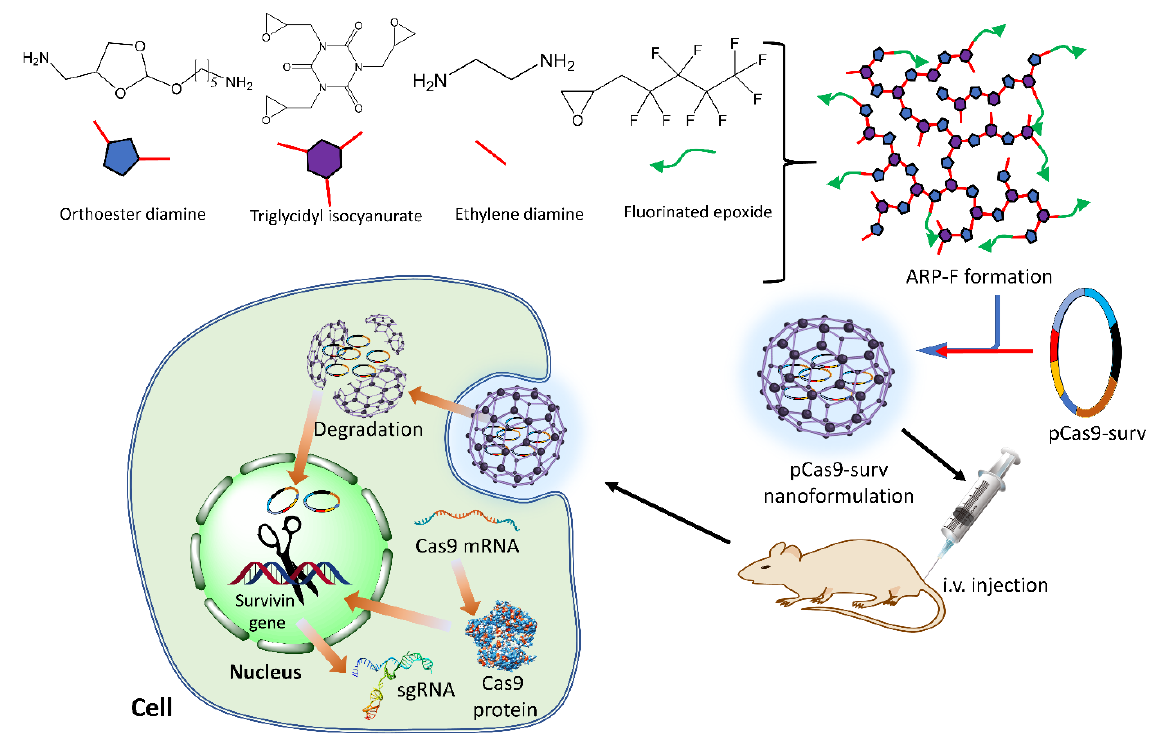
Figure 6. Molecular composition of ARP-F, its pCas9-suv nanoformulation preparation, and intracellular delivery strategy of CRISPR/Cas9 induced by pH response.